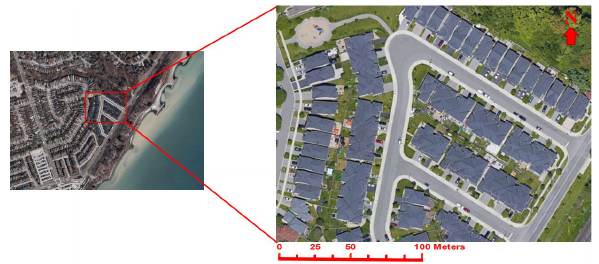
Figure 2. Study area - (Google Earth, 2020)